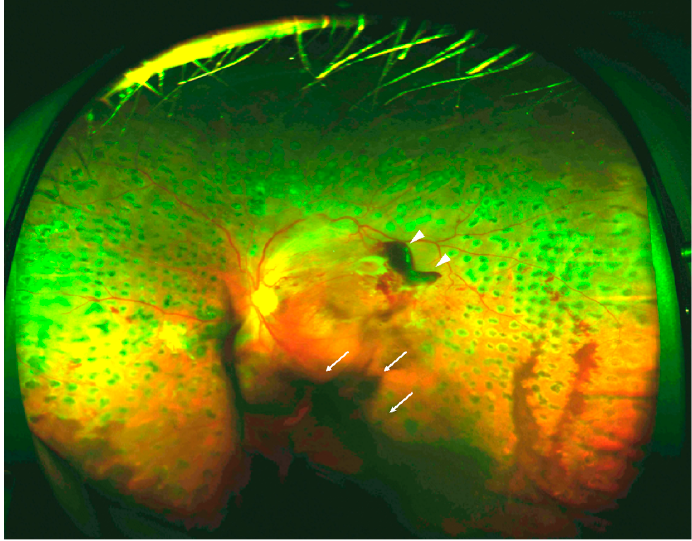
Figure 2. Fundus image of proliferative diabetic retinopathy (PDR) presenting with vitreous (arrow) and preretinal hemorrhage